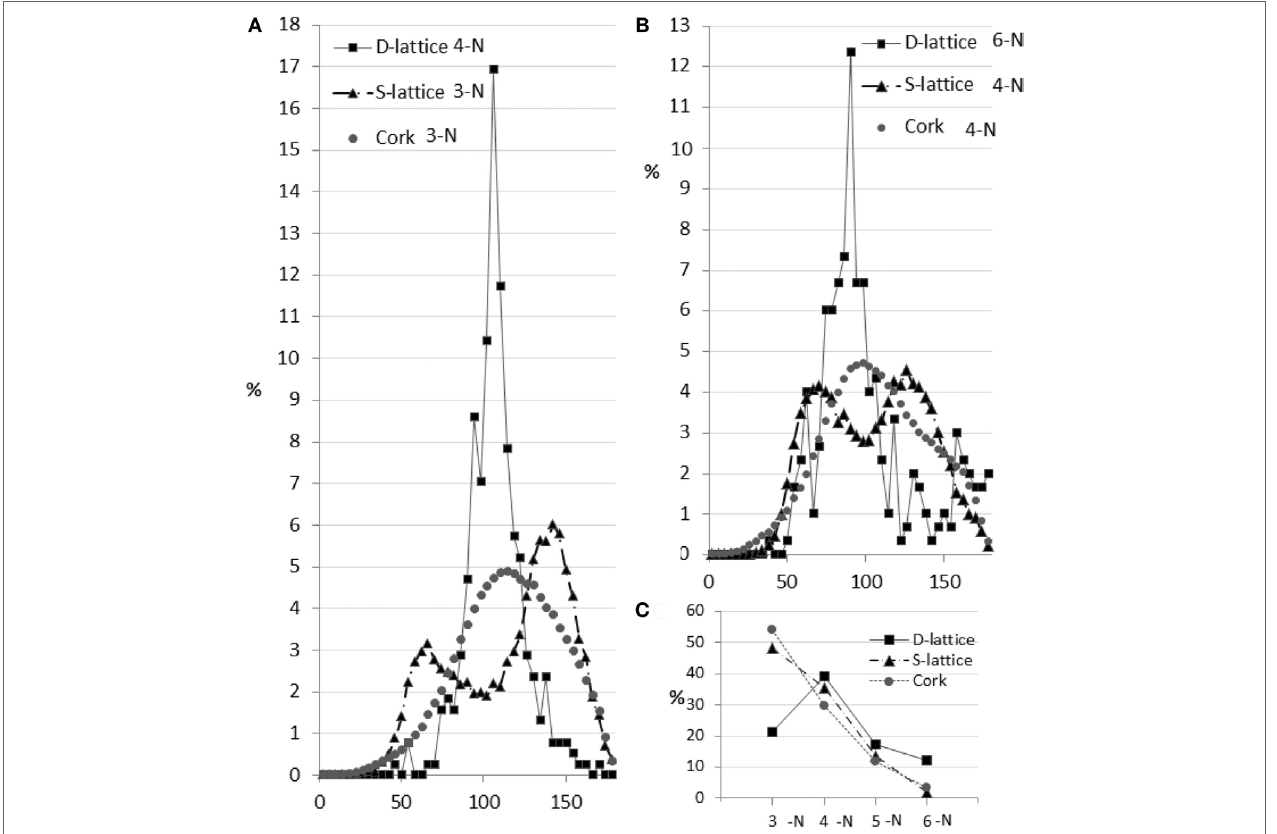
FigUre 4 | Topological characteristics of the three examined structures. Panel (a) shows ITA distributions of the most abundant node (4-N in D-lattice and 3-N in S-lattice and cork). In the D-lattice, the distribution is very narrow, reflecting the fact that this is a designed configuration. In the S-lattice the ITA distribution forms two distinct peaks, one at 60° and another, twice as tall, at 150°. Since the sum of such angles is 360°, these 3-N nodes are planar, but do not possess maximal offset of the edges. In cork, the ITA distribution is unimodal, centered around 116° and, therefore, these nodes in cork approximate a planar shape. Panel (B) shows the ITA distributions in the second most abundant nodes for three test samples. D-lattice demonstrates a narrow peak centered as expected based on its design. Note the higher count of ITA at the large angle values (explained in the Section “Discussion”). The S-lattice has a bimodal distribution with equal counts of values around 60° and 120°, which is consistent with a planar structure with non-uniform offset of edges. The cork ITA distribution is similar to bone in shape and width and centers around 107°. That is indicative of the maximal angular offset. Panel (c) shows the node abundance as a function of the number of neighbors. The cork trend decays exponentially and is similar to bone; the S-lattice node abundance decays linearly; the D-lattice trend is consistent with the design and the surface cropping